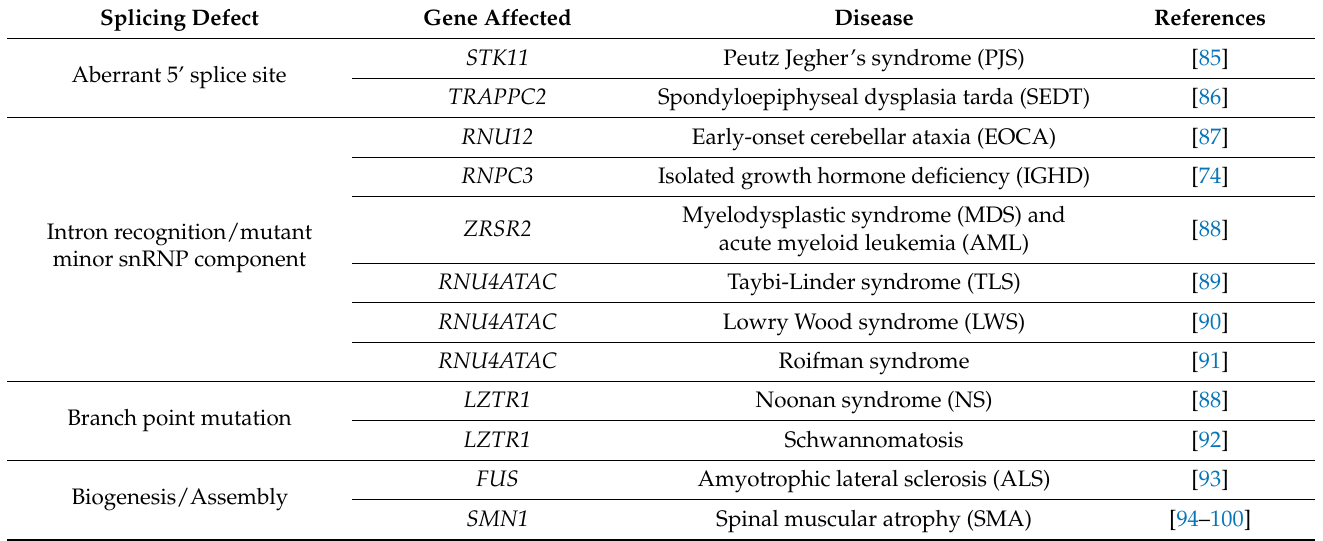
Table 1. Human diseases associated with defects in minor intron